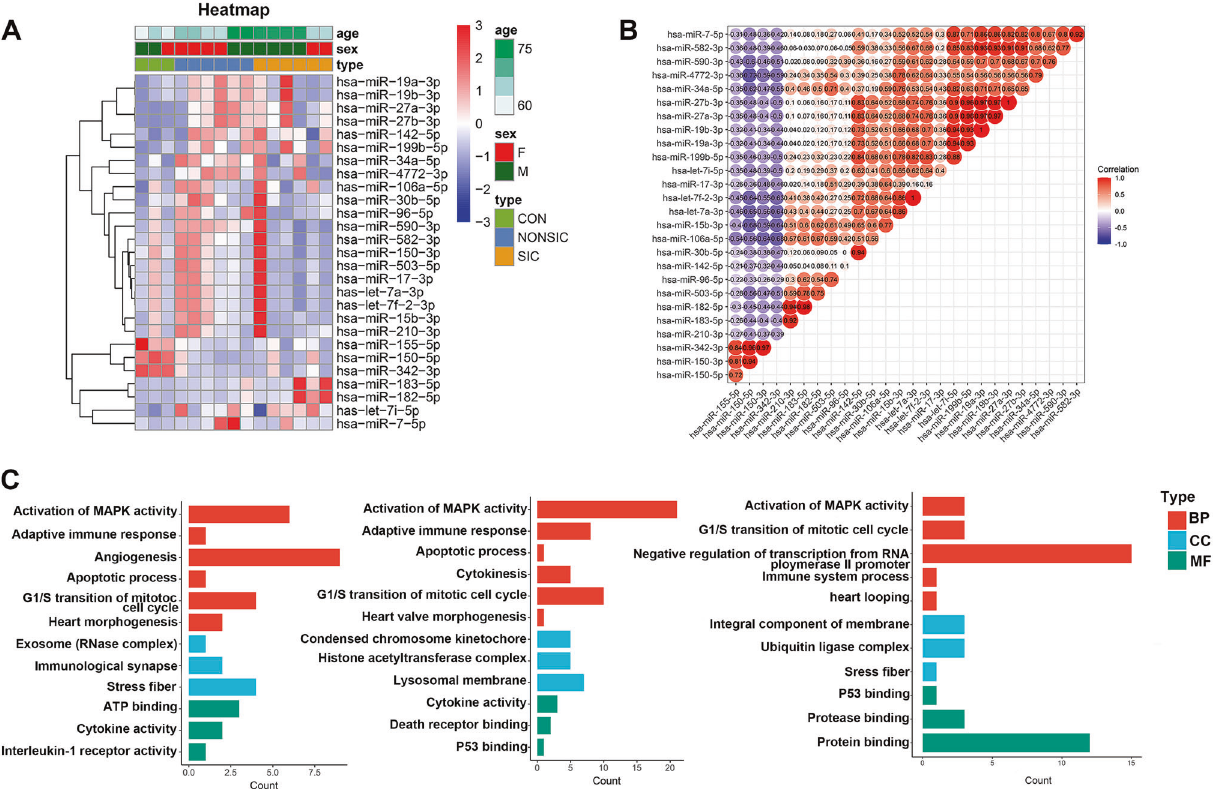
Fig. 2 The 27 differentially expressed miRNAs commonly existed in both groups of non-SIC and SIC as compared to the control participants. A Hierarchical cluster analysis of the 27 common differentially expressed miRNAs. B Correlation matrix for all 27 common differentially expressed miRNAs. Some differentially expressed miRNAs were negatively related (highlighted in blue), and others were positively related (highlighted in red). The darker the color, the higher the correlation was ( p < 0.05) C . GO enmrichment analysis on the three subclasses of protein for the Con vs. NonSIC, Con vs. SIC, NonSIC vs.